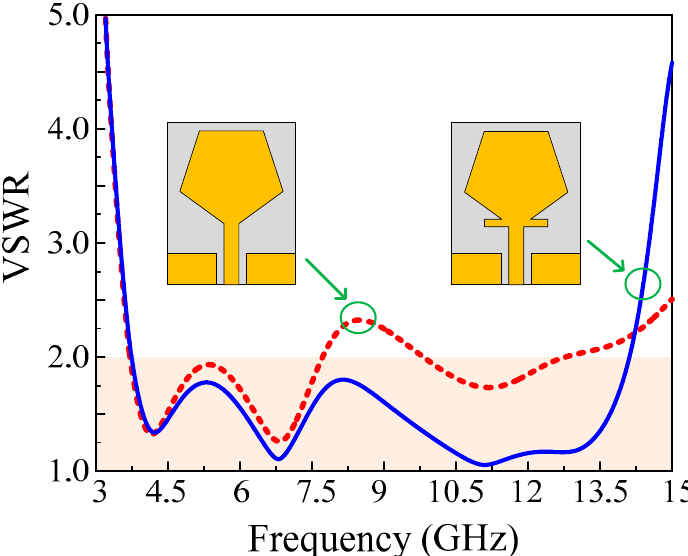
Figure 4. VSWR response of the radiating element with and without the stub.